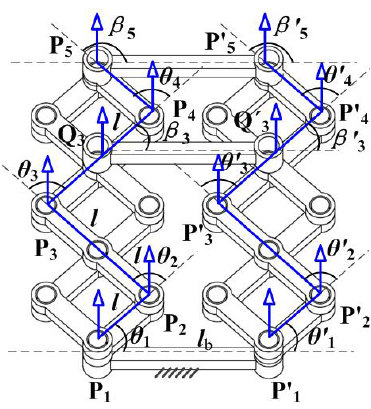
Figure 3. Structure of novel SLE-Pa leg in case 3.